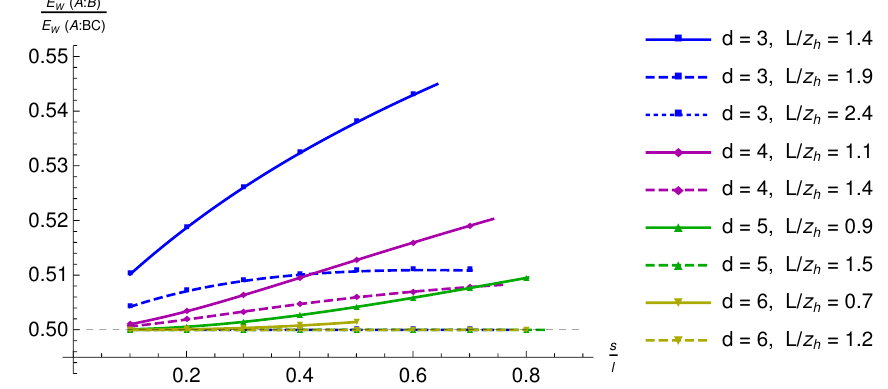
Figure 13 . The ratio of the wedges E W ( A : B ) /E W ( A : BC ) in the S C phase in the AdS soliton background as a function of s/l for various d and total widths L = 3 l + 2 s